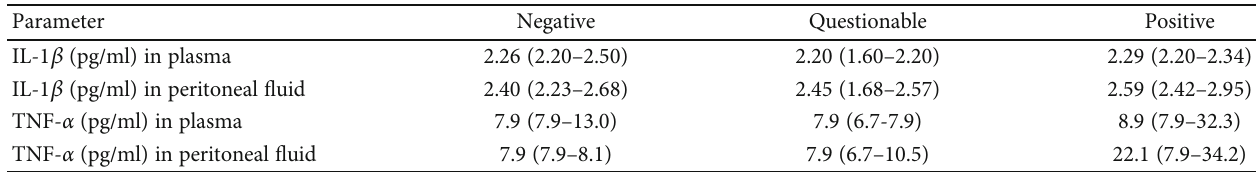
Table 6: IL-1 β and TNF- α concentrations in plasma and peritoneal fl uid in the groups negative ( n = 32 , ≤ 6/19 points), questionable ( n = 8 , 7- 9/19 points), or positive ( n = 6 , ≥ 10/19 points) for sepsis. Median (lower quantile – upper quantile). No signi fi cant di ff